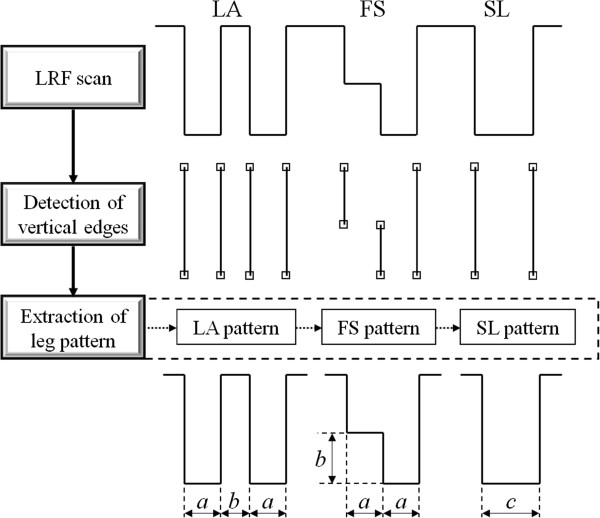
Schematic representation of the leg detection algorithm [18].